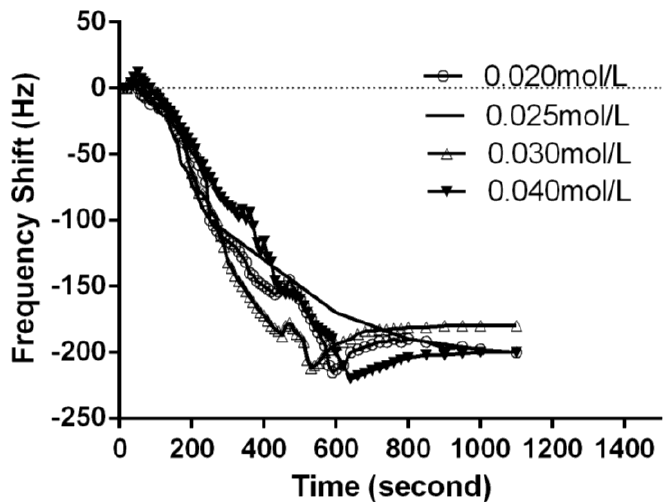
Figure 3. The effect of calcium chloride concentration on coagulation